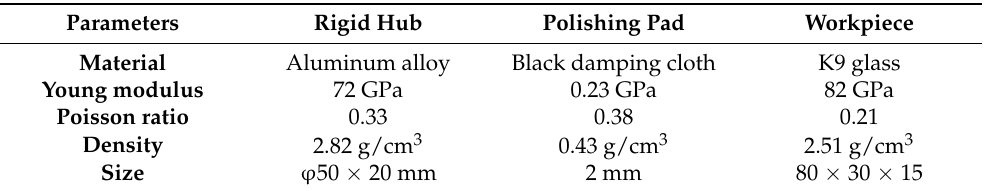
Figure 4. Finite element model. Table 1. Material parameters.